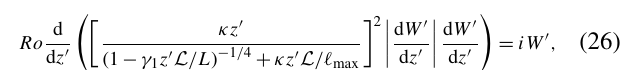
wind profile (Lettau, 1950), which equating with (cid:96) max